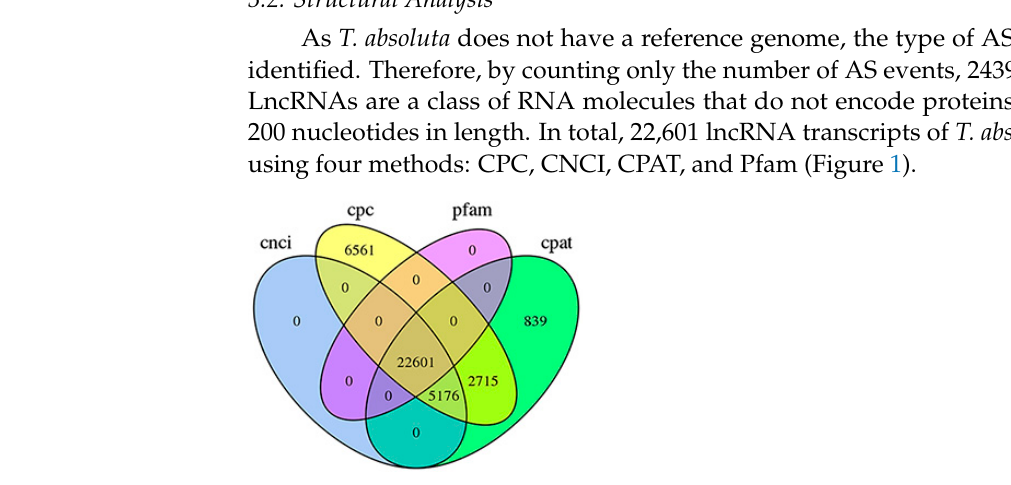
Figure 1. Venn diagram of lncRNA transcripts identified from PLEK, CNCI, CPC, and Pfam. The values in the figure represent the common and non-common parts of each subset.